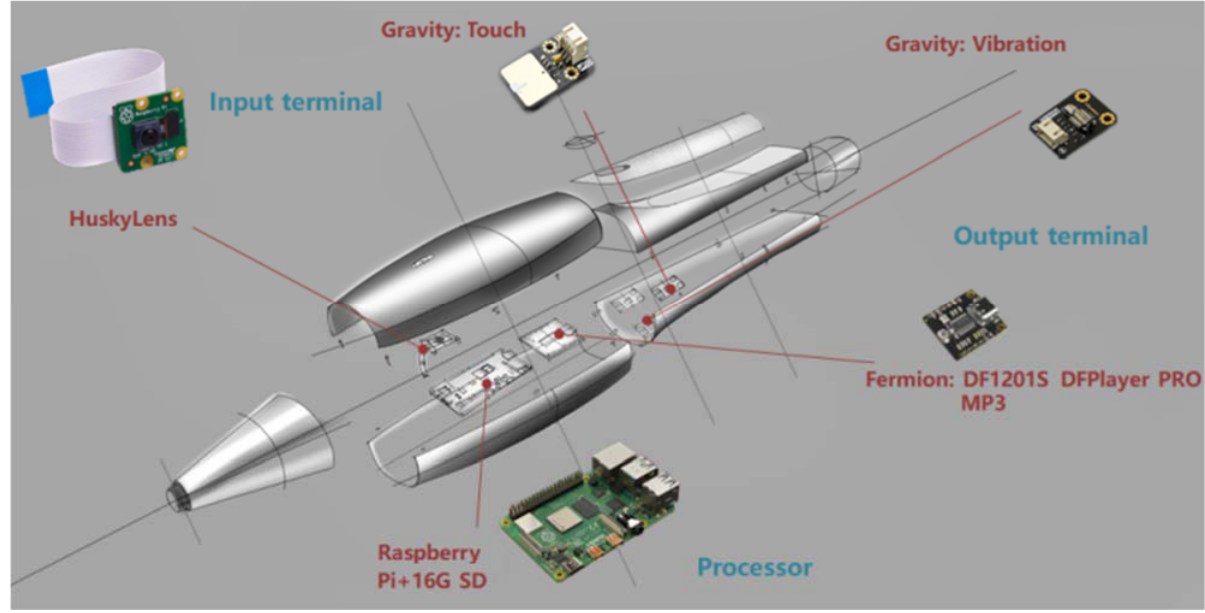
Figure 3. The five main components of the hardware engineering